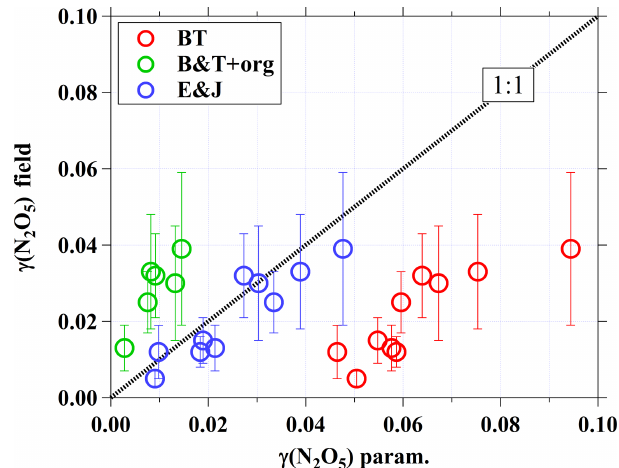
Figure 5. Comparison of field-derived N 2 O 5 uptake coefficients with values computed from different parameterizations. The dashed line represents 1 : 1, and the error bars show the uncertainty in γ (N 2 O 5 ) derived from the